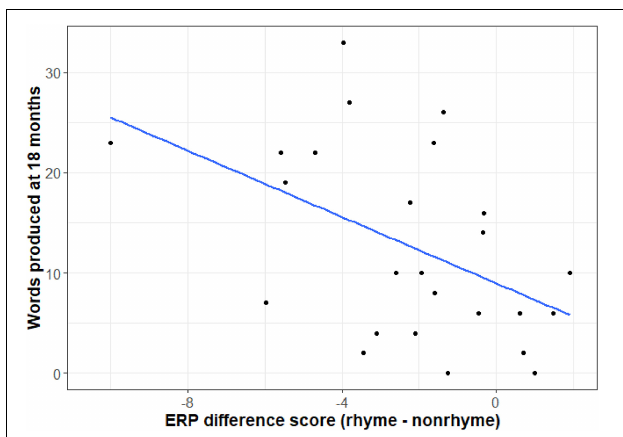
FIGURE 3 | Correlation between words produced at 18 months (y-axis) and ERP difference scores (rhyme – non-rhyme, averaged for the cluster electrodes and time window) on the x-axis: τ = -0.3, p = 0.03. The correlation remains marginally significant when excluding the outlier at ( − 10, 23): τ = -0.3, p =